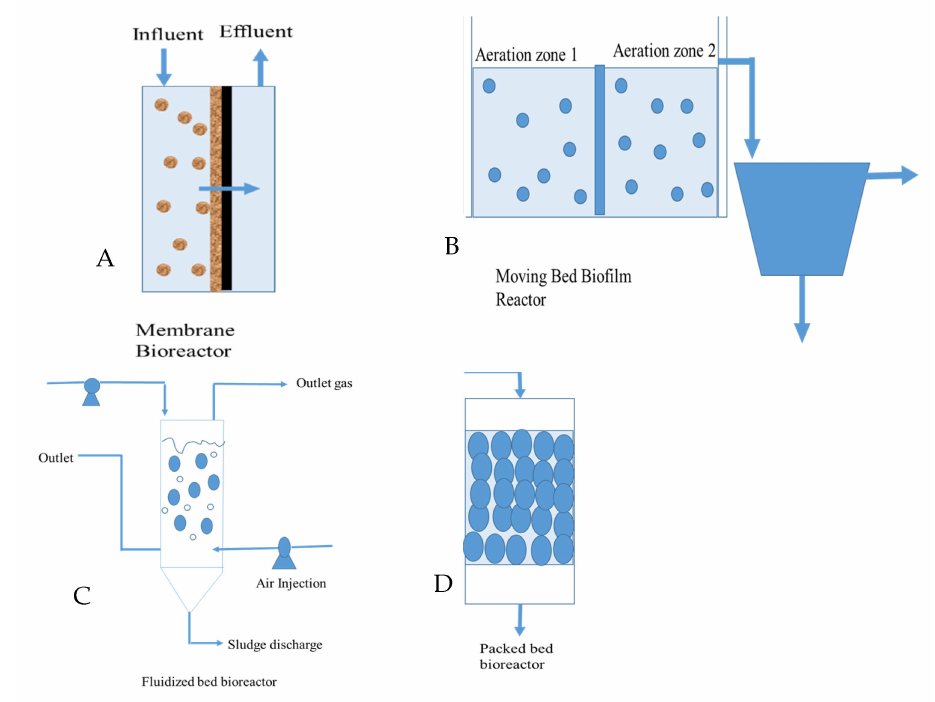
Figure 3. Illustration of popular biofilm reactors for wastewater treatment: ( A ) membrane bioreactor; ( B ) moving bed biofilm bioreactor; ( C ) fluidized bioreactor; ( D ) packed bed